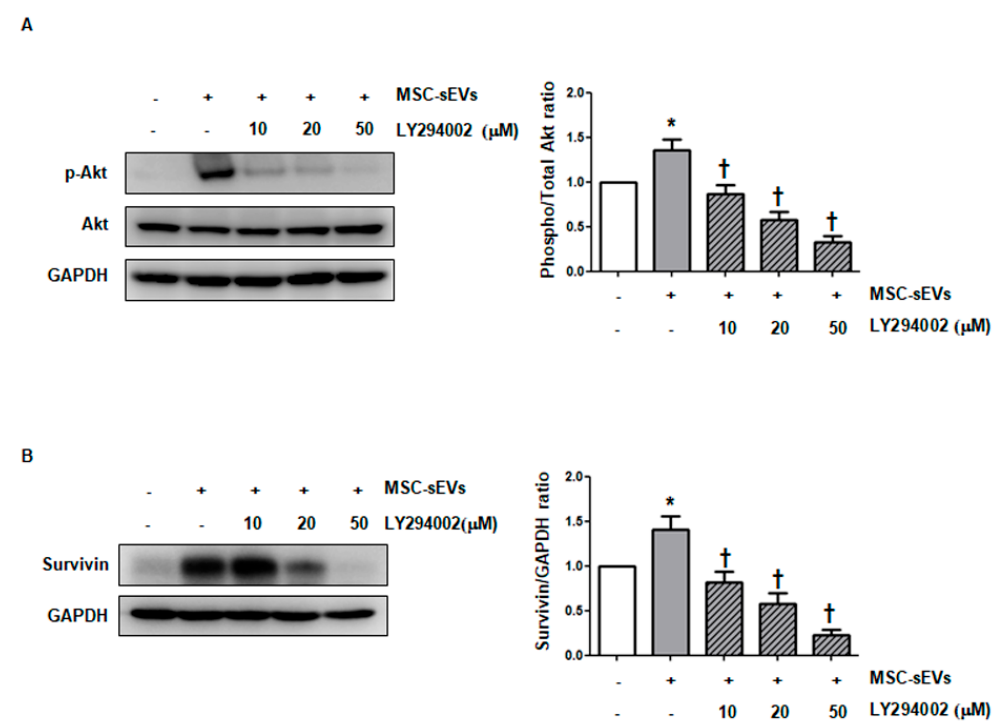
Figure A3. Inhibition of Akt activation downregulates survivin expression induced by MSC − sEVs. H9c2 cells were exposed to MSC − sEVs after being treated with LY294002 at the indicated concentrations for 2 h. Cells were harvested after 1 h ( A ) or 24 h ( B ) incubation. The protein levels of p − Akt, Akt, survivin, and GAPDH were measured by Western blotting ( n = 5). * Significant difference compared to the control ( p < 0.05). † Significant difference compared to MSC − sEVs treatment ( p < 0.05).